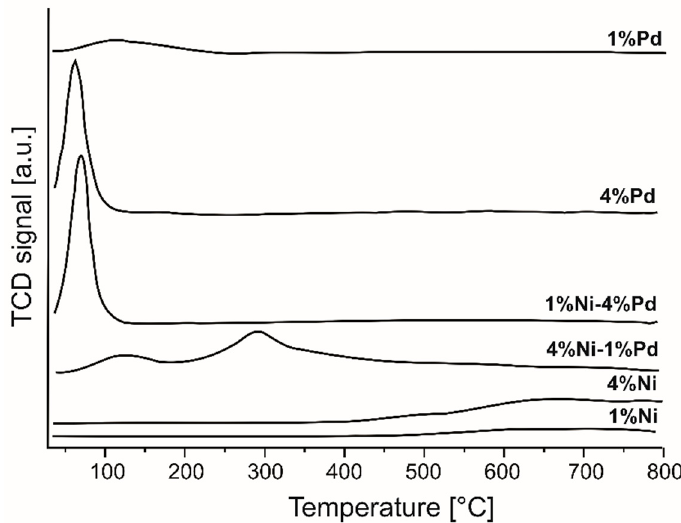
Figure 1. Temperature Programmed Reduction (TPR) profiles of mono and bimetallic catalysts after the oxidation step.